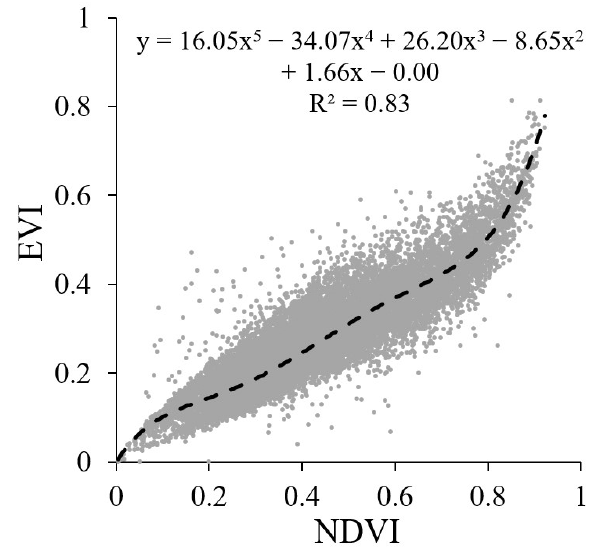
Figure 13. Relationship between NDVI and EVI for sampled data used in this study.